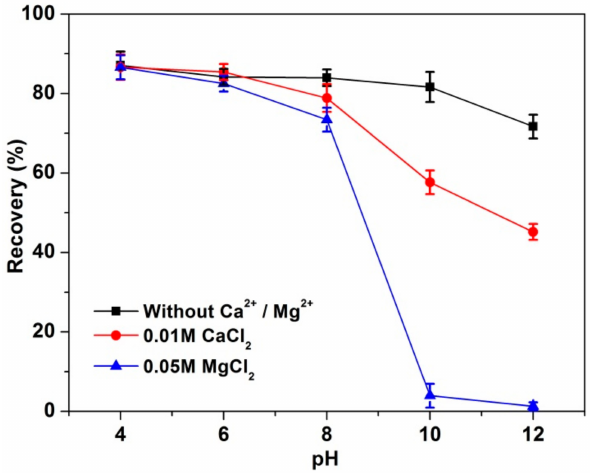
Figure 4. MoS 2 recovery at various pH